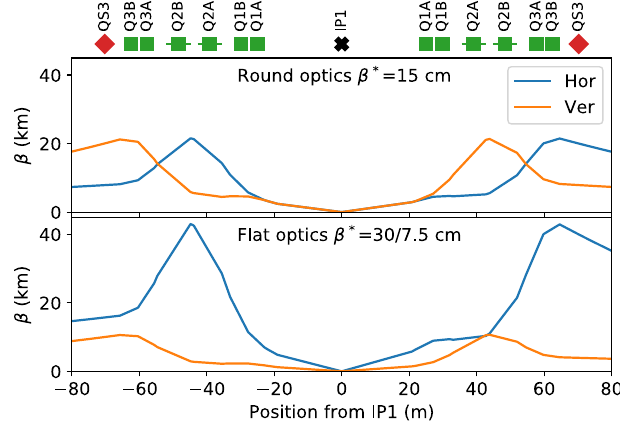
FIG. 2. Schematic of the quadrupoles layout and β -function in the triplet region of HL-LHC around IP1 for round and flat